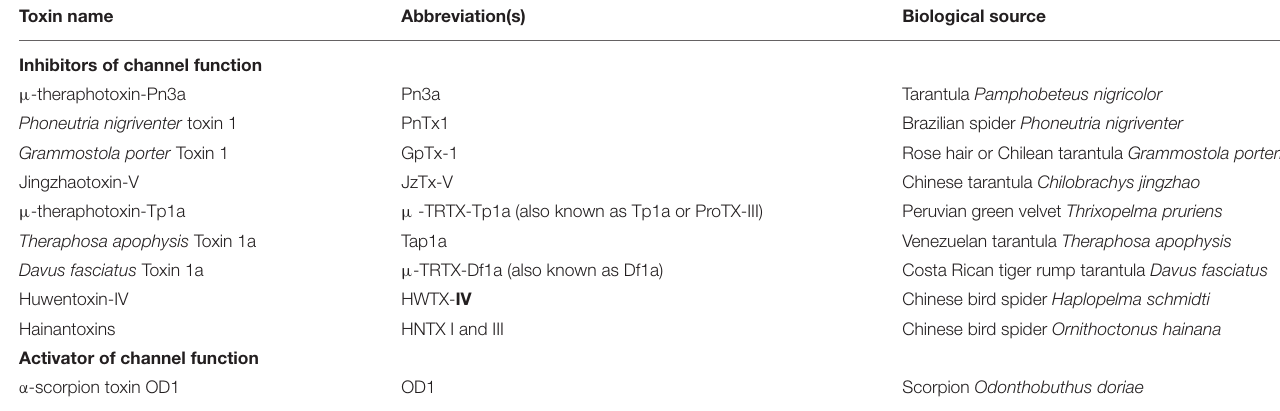
TABLE 2 | List of toxins that modulate Na v 1.7 channel